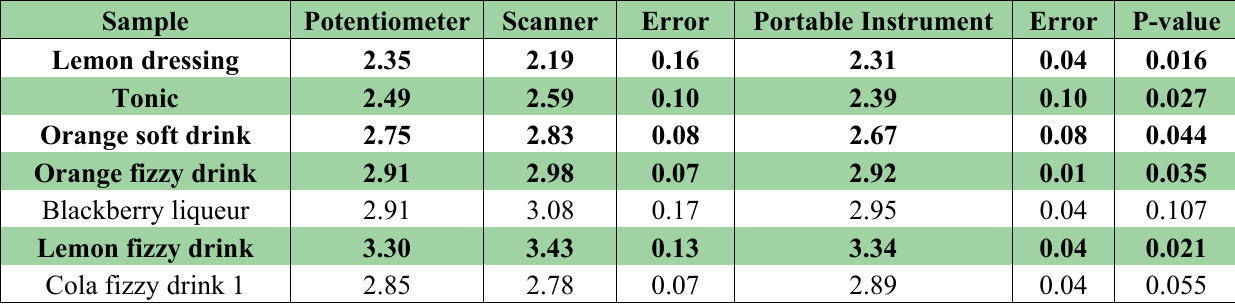
Table 2. Comparison between the pH of different samples measured with different devices.